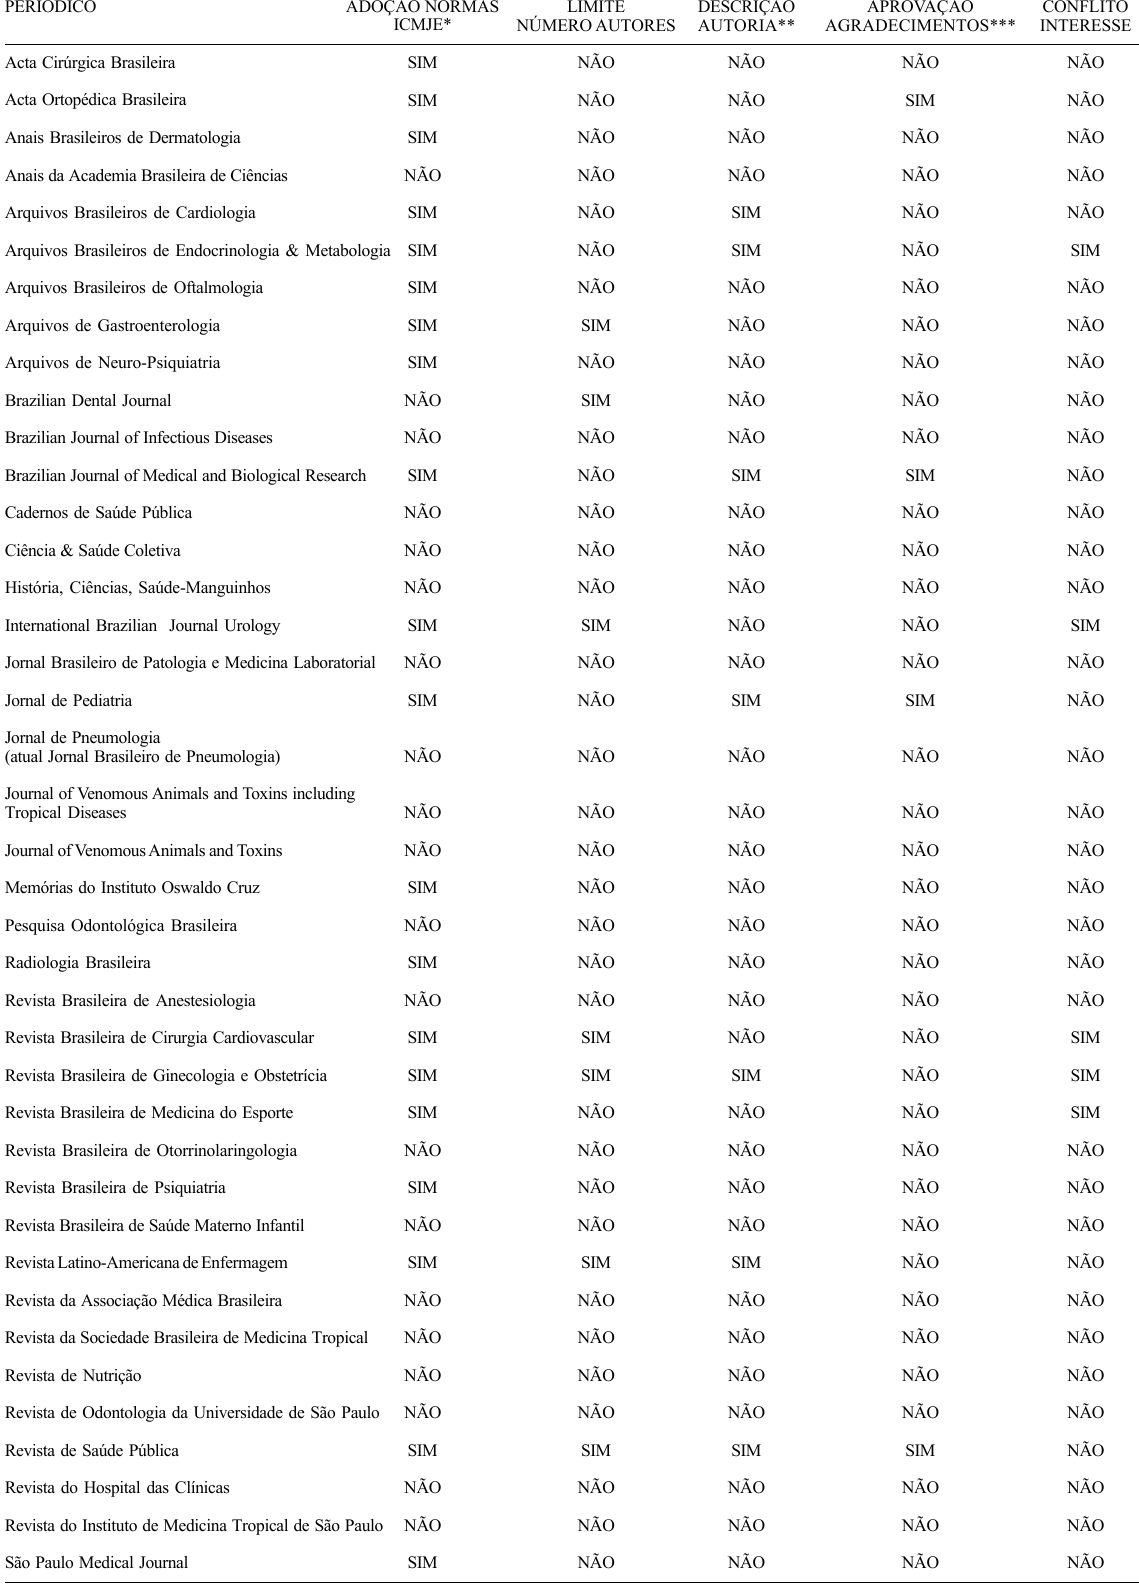
Tabela 1. Revistas da Área da Saúde na SciELO em maio/2004.